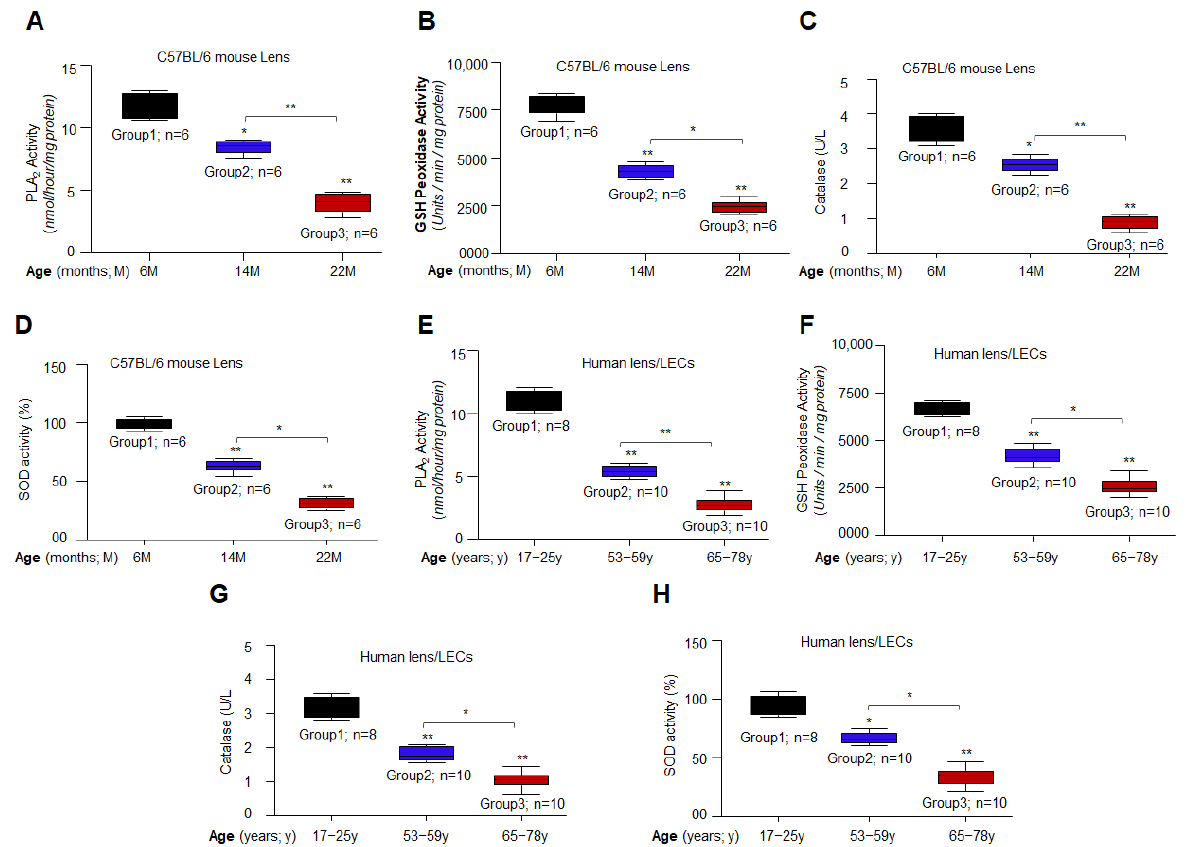
Figure 2. Aging/aged C57BL/6 mouse lenses or hLECs exhibited a significant reduction in phospholipase A2, GSH peroxidase, Catalase and SOD activities. ( A – D ) Total protein was isolated from different ages of mouse lenses and processed for analyses of the enzymatic activities. Increasing decline of aiPLA 2 ( A ), GSH peroxidase ( B ), Catalase ( C ) and SOD ( D ) activities were observed in lenses with aging. Data represents the mean ± S.D. from three independent experiments. Younger (6 M) vs. aging (14 M and 22 M) samples. * p < 0.05; ** p < 0.001. ( E – H ) Primary hLECs isolated from lenses of different ages were divided into three groups: 17 – 25 y (n = 8); 53 – 59 y (n = 10) and 65 – 78 y (n = 10). Total protein was isolated from hLECs of different ages as indicated in Figures and was processed for estimating their enzymatic activities. The data represent the mean ± S.D. from three independent experiments. Younger (17 – 25 y) vs. aging (53 – 59 y and 65 – 78 y) samples. * p < 0.05; ** p < 0.001.